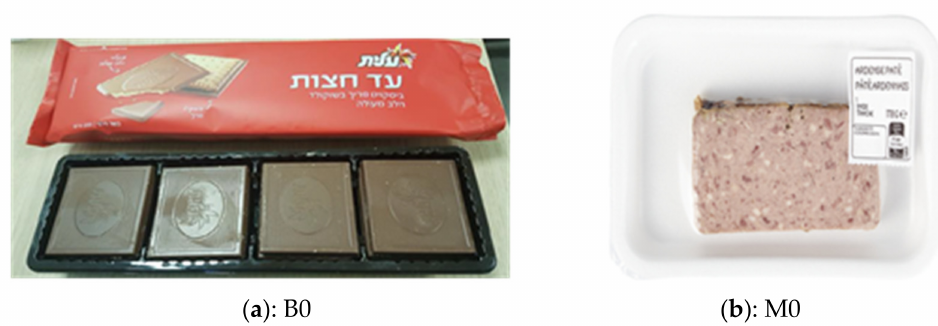
Figure 1. Examples of currently available packages discussed in Stage 1: ( a ) B0: Biscuit package; ( b ) M0: meat package.